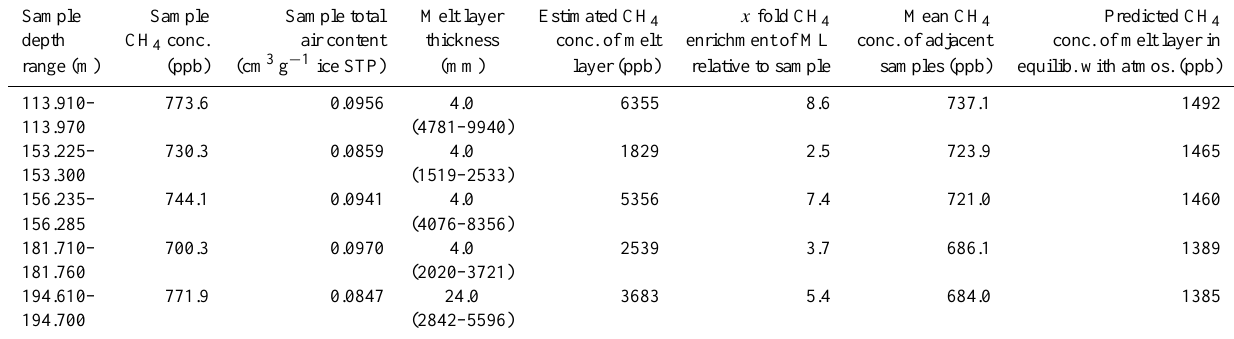
Table 2. Discrete CH 4 and total air content measurements on Tunu13 samples containing melt layers. Estimated CH 4 concentrations of the melt layers result from a simple mixing calculation using air content measurements made on Summit melt layer samples. Values in parentheses reflect the range of melt layer air content values measured. Predicted CH 4 values are calculated using the assumption that the melt layer was in equilibrium with the atmosphere, according to Henry’s Law (0 ◦ C, 0.750atm.). Henry’s Law constants for CH 4 , O 2 and N 2 were obtained from NIST Chemistry WebBook (http://webbook.nist.gov/cgi/cbook.cgi?Name=methane&Units=SI&cSO=on). CH 4 concentrations of adjacent samples are used as atmospheric concentrations at time of melt layer formation. All of these samples are from the Tunu13 Main